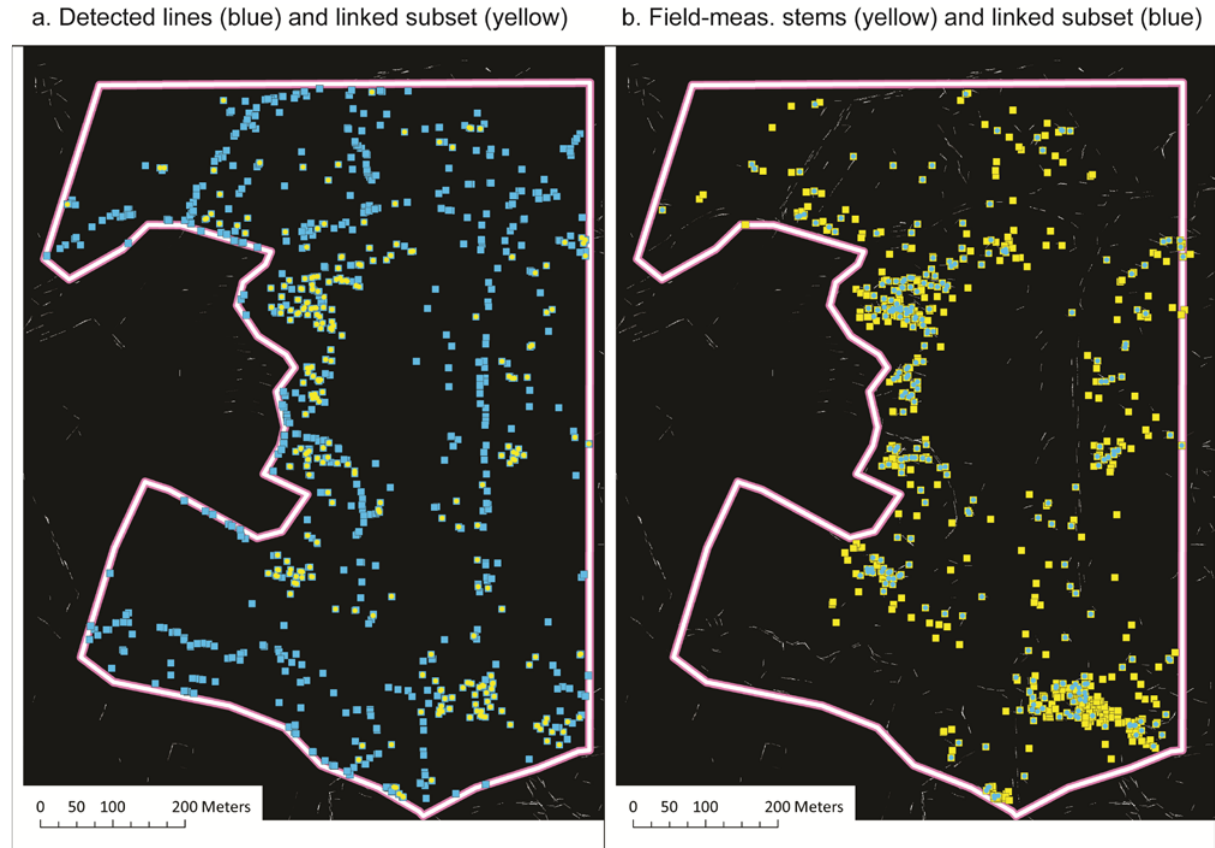
Figure 6. The linking between lines detected from the line template matching algorithm and the field-measured stems in the inventory area on a raster image of the vectorized lines. All detected lines shown in blue and the subset of lines linked to field-measured stems in yellow (a). All field-measured stems shown in blue and the subset of stems linked to detected lines in yellow